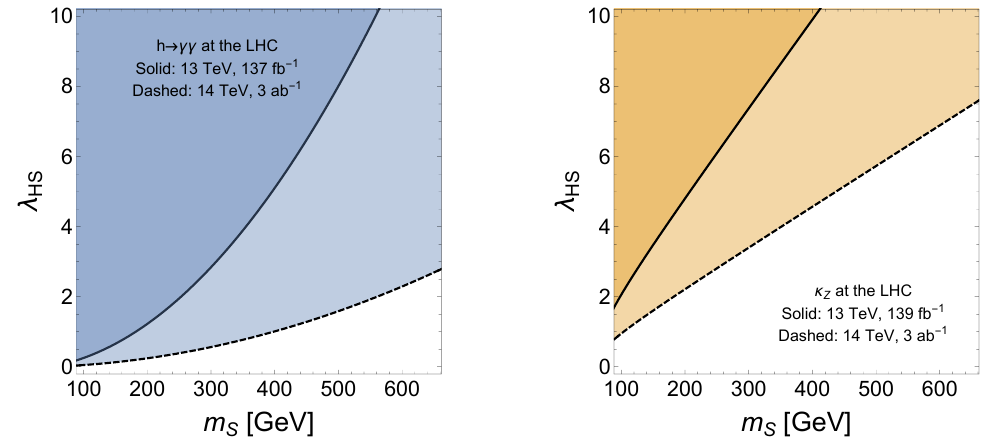
Figure 10 . The shaded regions are constraints and projections from the hγγ and hZZ coupling measurements at the